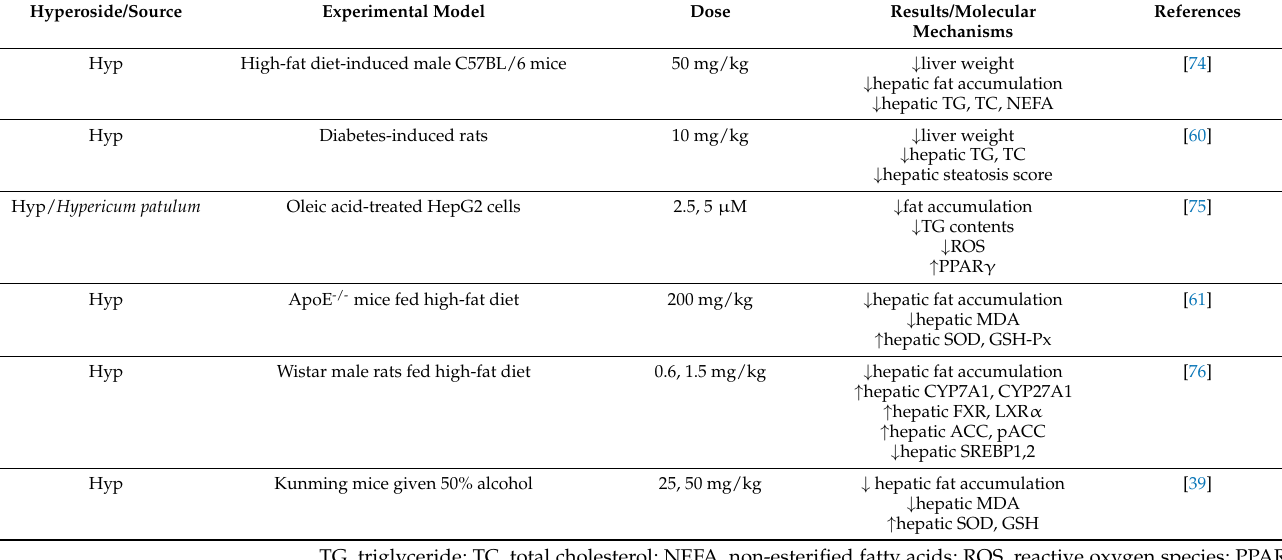
Table 3. Antisteatotic activities of hyperoside (Hyp) in experimental models related to hepatic steatosis. Hyperoside/Source Experimental Model Dose Results/Molecular